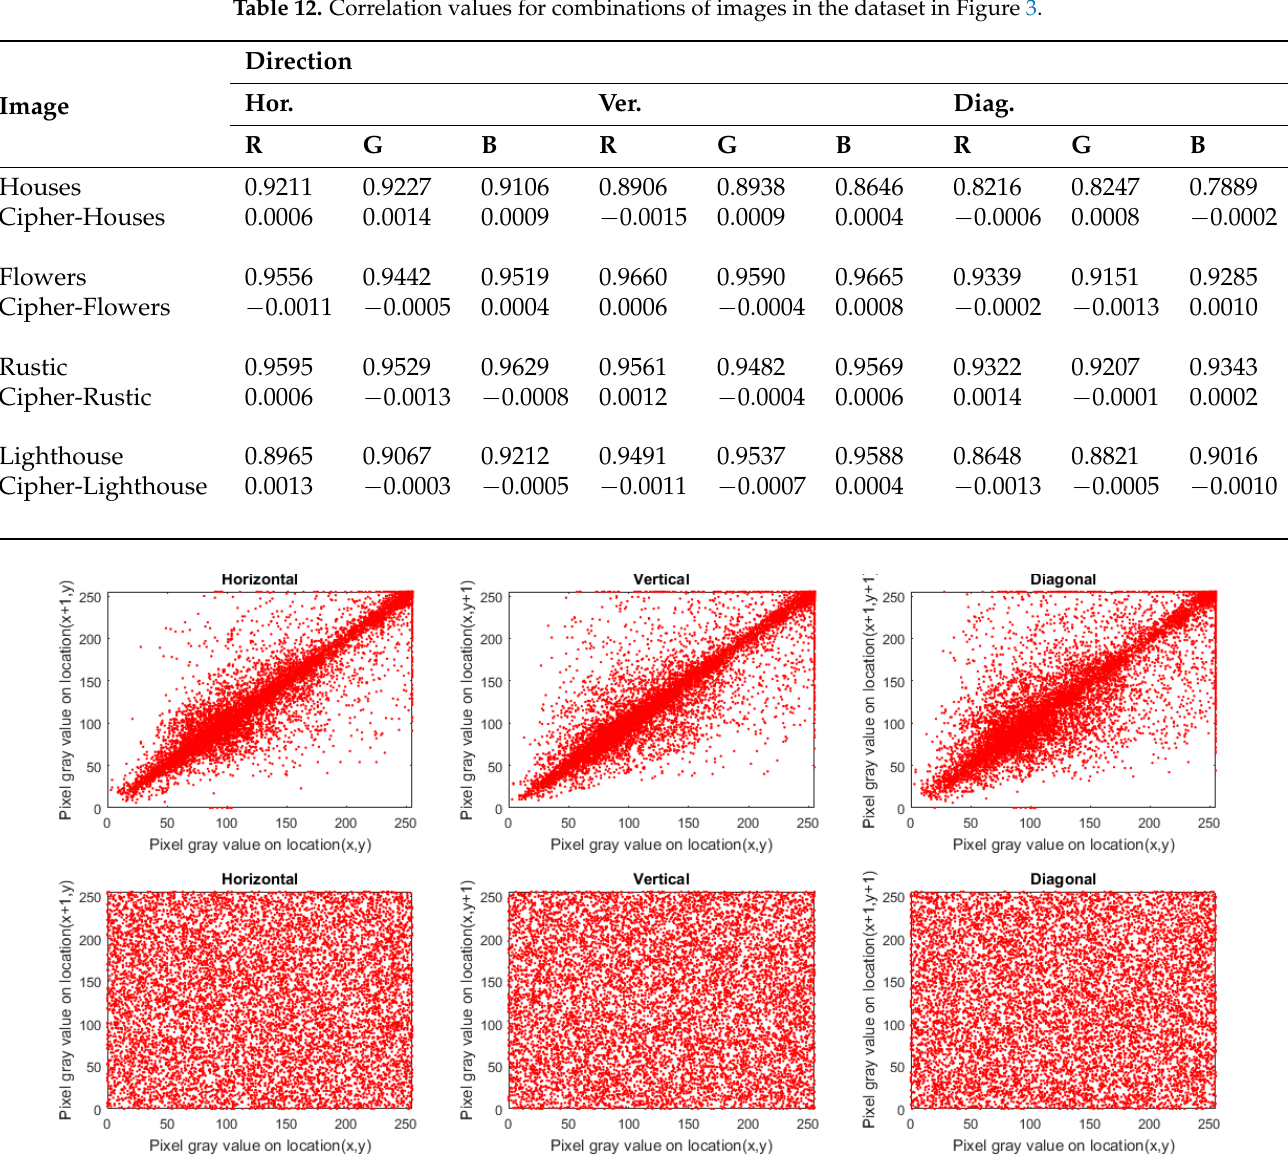
Figure 4. Correlation distribution of plain and ciphered Houses images for the red